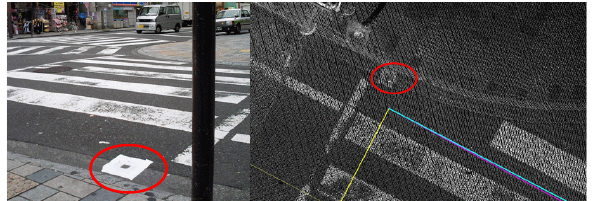
Figure 7. A targeting point for MMS accuracy verification